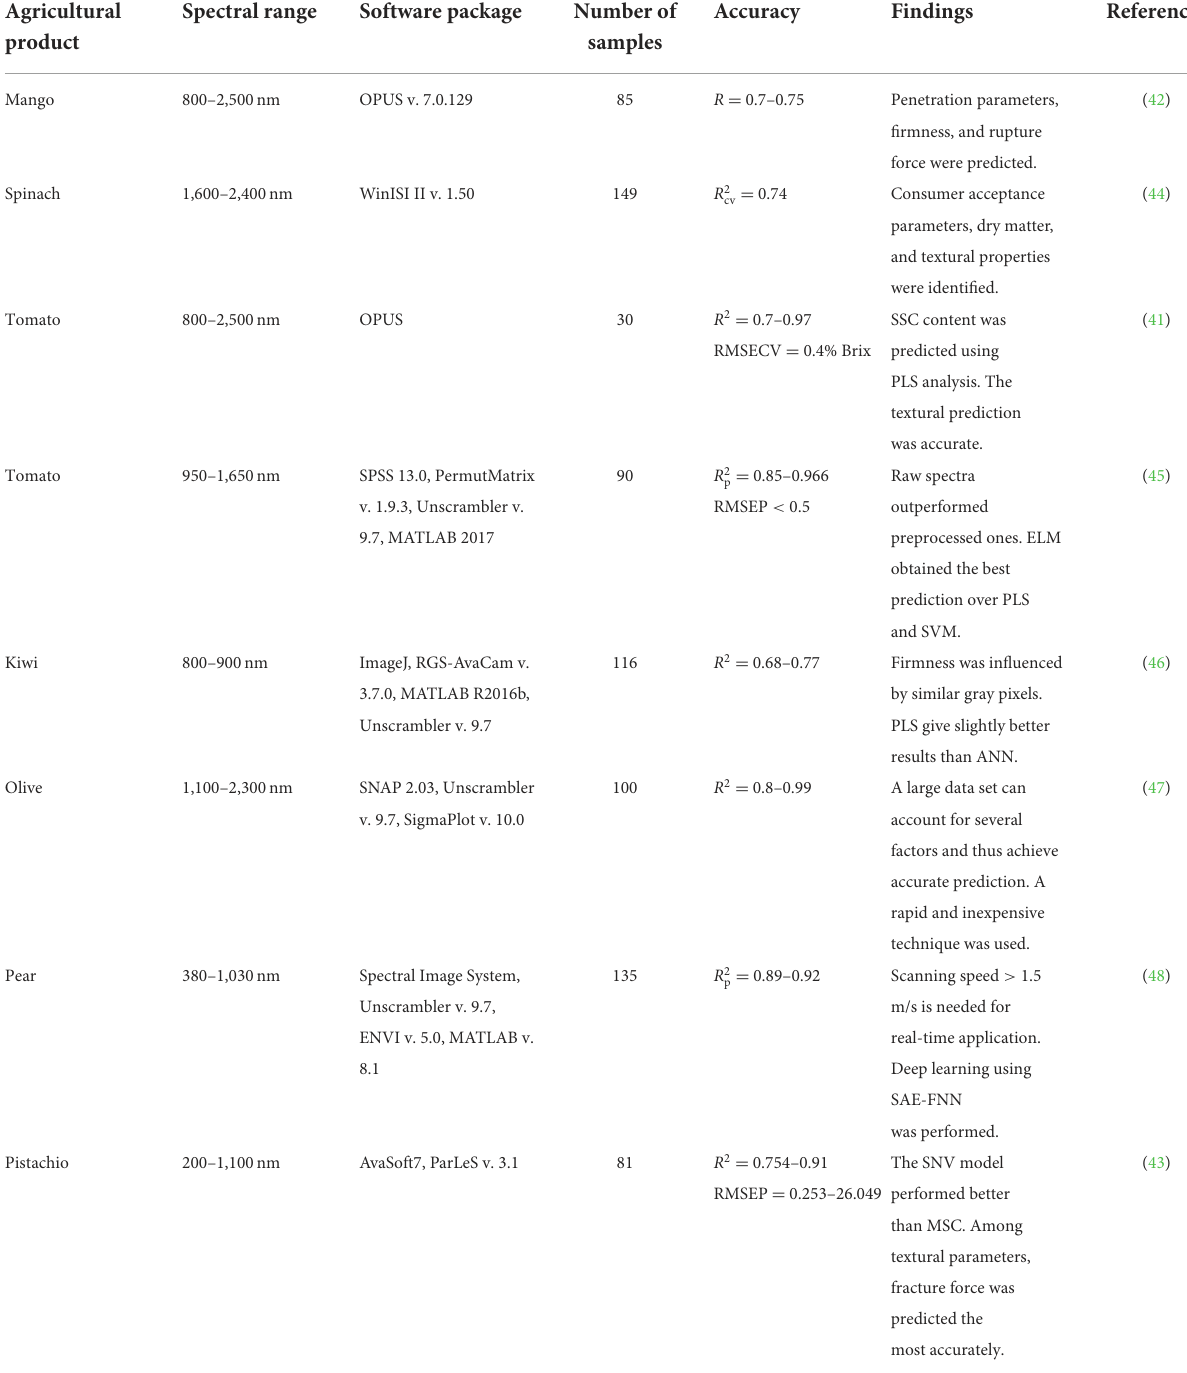
SSC,solublesolidcontent;RMSEP,rootmeansquareerrorofprediction;RMSECV,root-mean-squareerrorofcross-validation;PLS,partialleastsquares;ELM,extremelearningmachines;